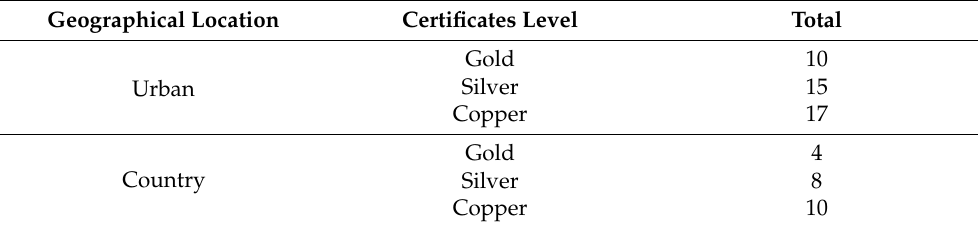
Table 1. Distribution of Green Hotel Certificates in Taiwan.